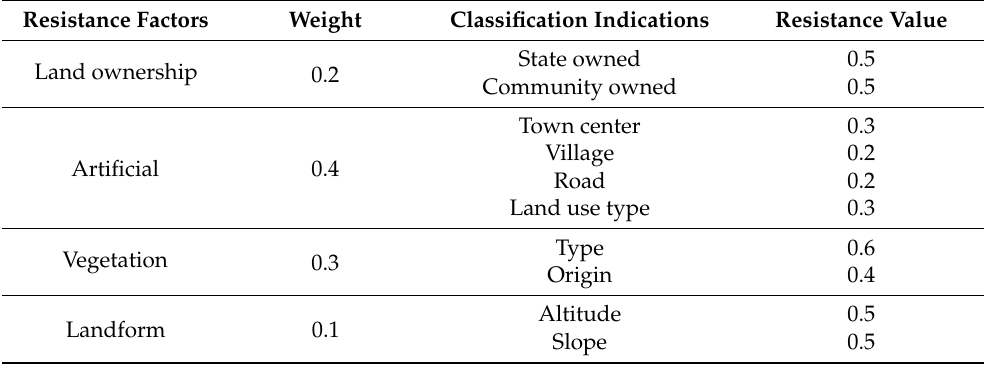
Table 1. Assignment of resistance